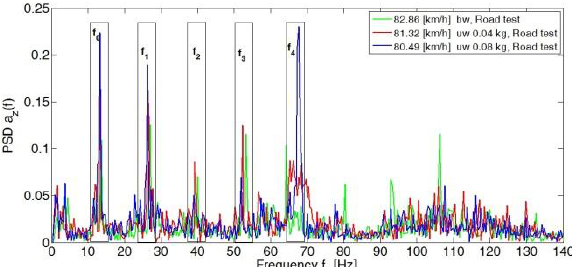
Figure 7. Power spectral density graph of the body acceleration signal for a speed of 80 km/h.